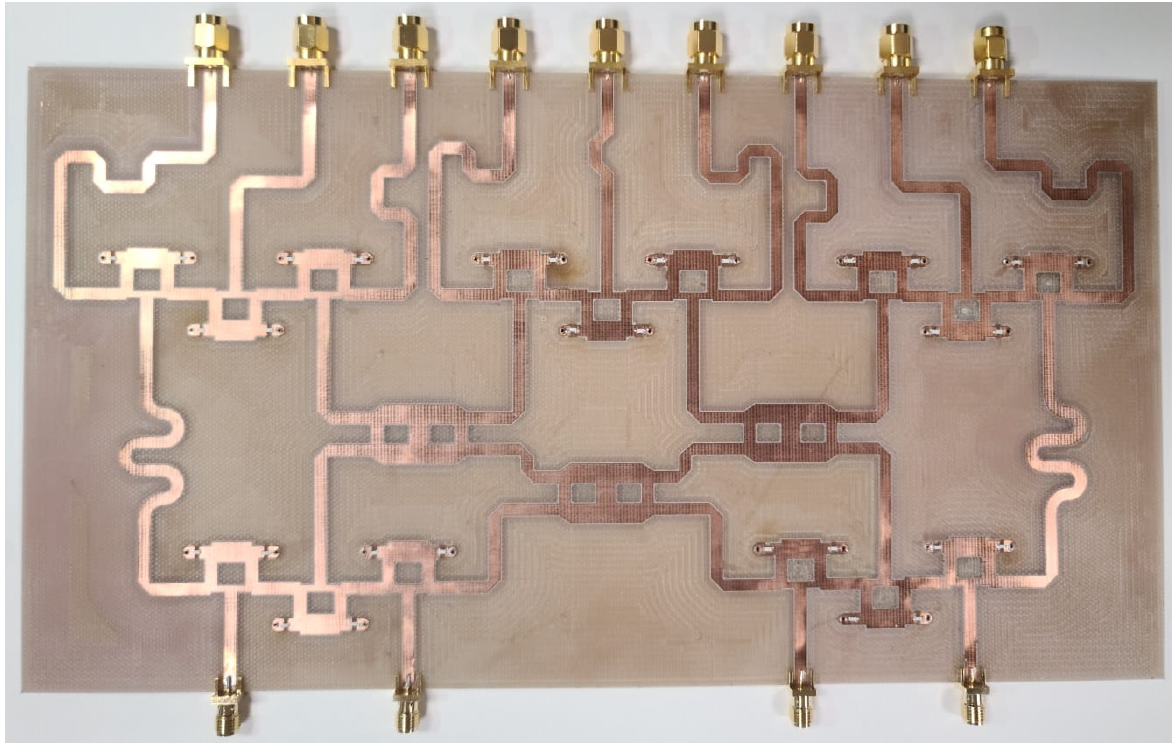
Figure 6. Fabricated prototype of the proposed feeding system.